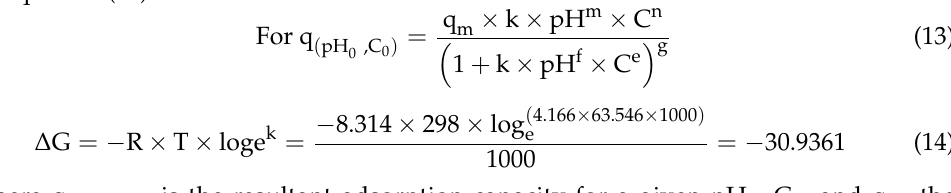
e ) vs. initial pH and C 0